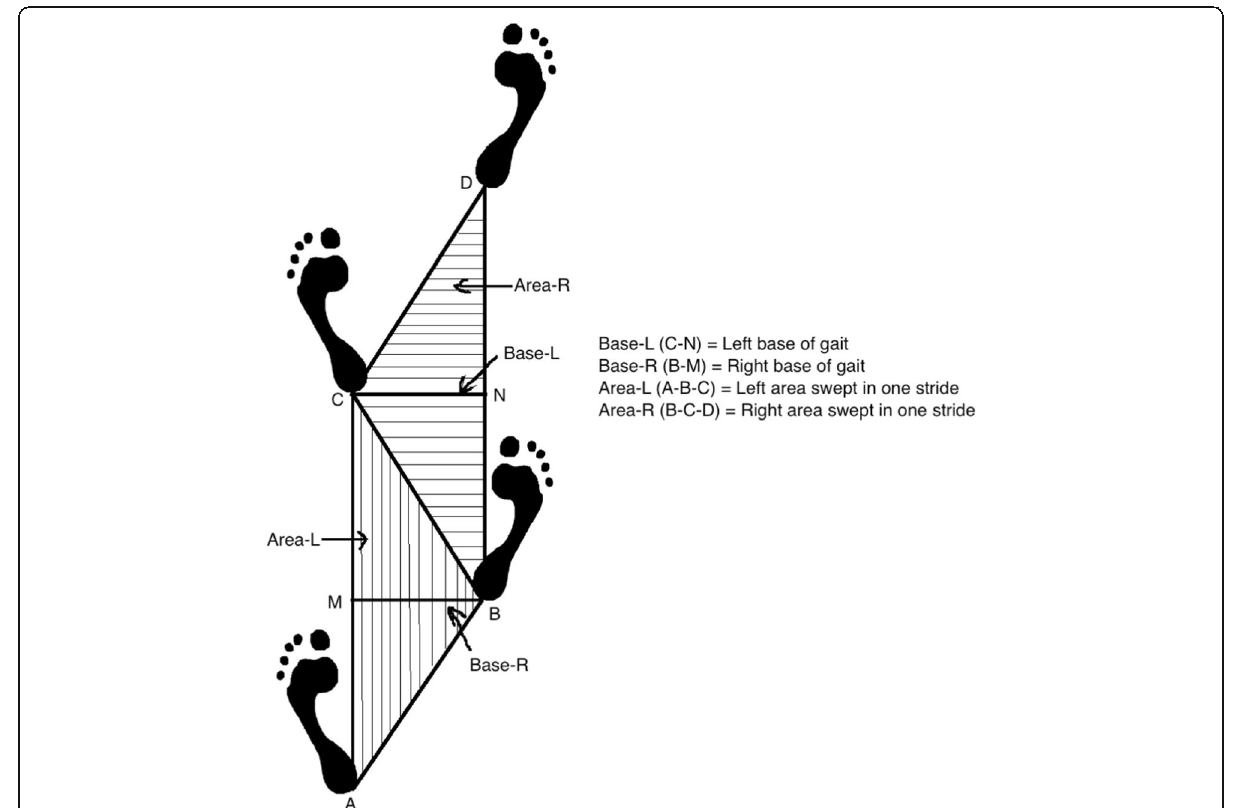
Fig. 1 A schematic representation of “ base of gait ” and “ area swept in one stride